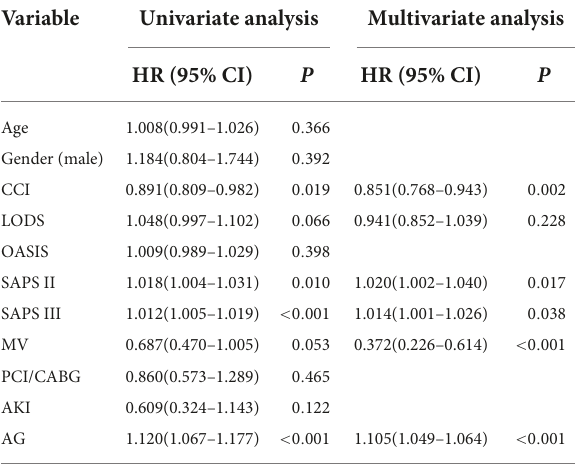
TABLE 5 Cox regression analyses of risk factors for in-hospital mortality among coronary care unit patients with AMI (after PSM). Variable Univariate analysis Multivariate